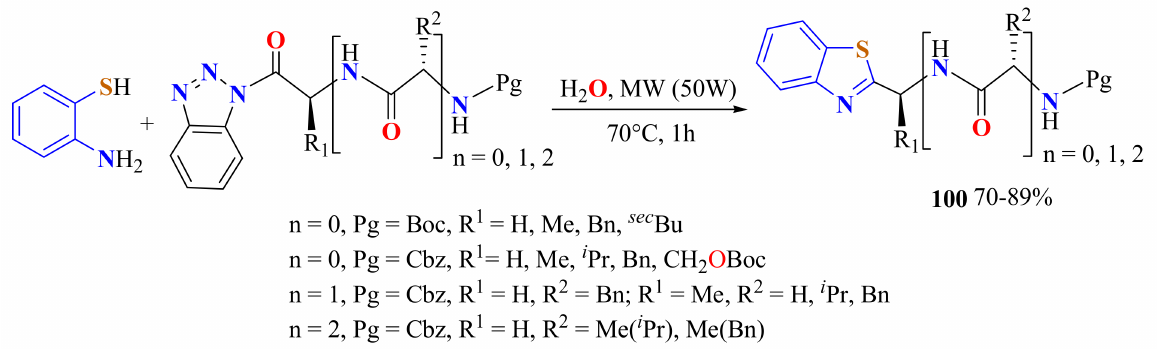
Scheme 82. Condensation of ATP with peptidylbenzotriazolides in H 2 O under MWI. Condensation of ATP with (un)substituted p -aminobenzoic acids under the action of melamine formaldehyde resin (MFR)-supported sulfuric acid under microwave irradiation (900 W) and solvent-free conditions was performed (Scheme 83). The simple method afforded 2-(4-aminophenyl)BTs 101 in 81–88% yields in 6–8 min. The catalyst could be recycled three times, with the yield lowering from 87% to 80%